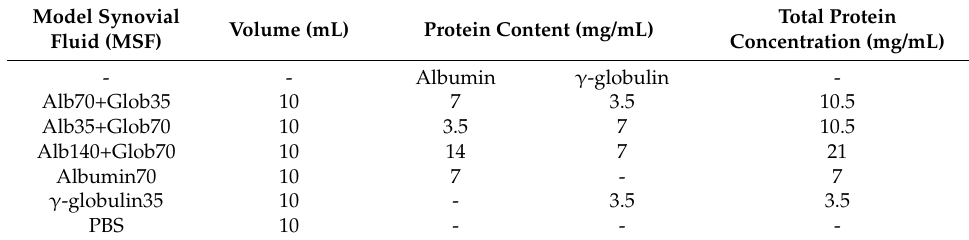
Table 2. Summary of the applied model fluids.